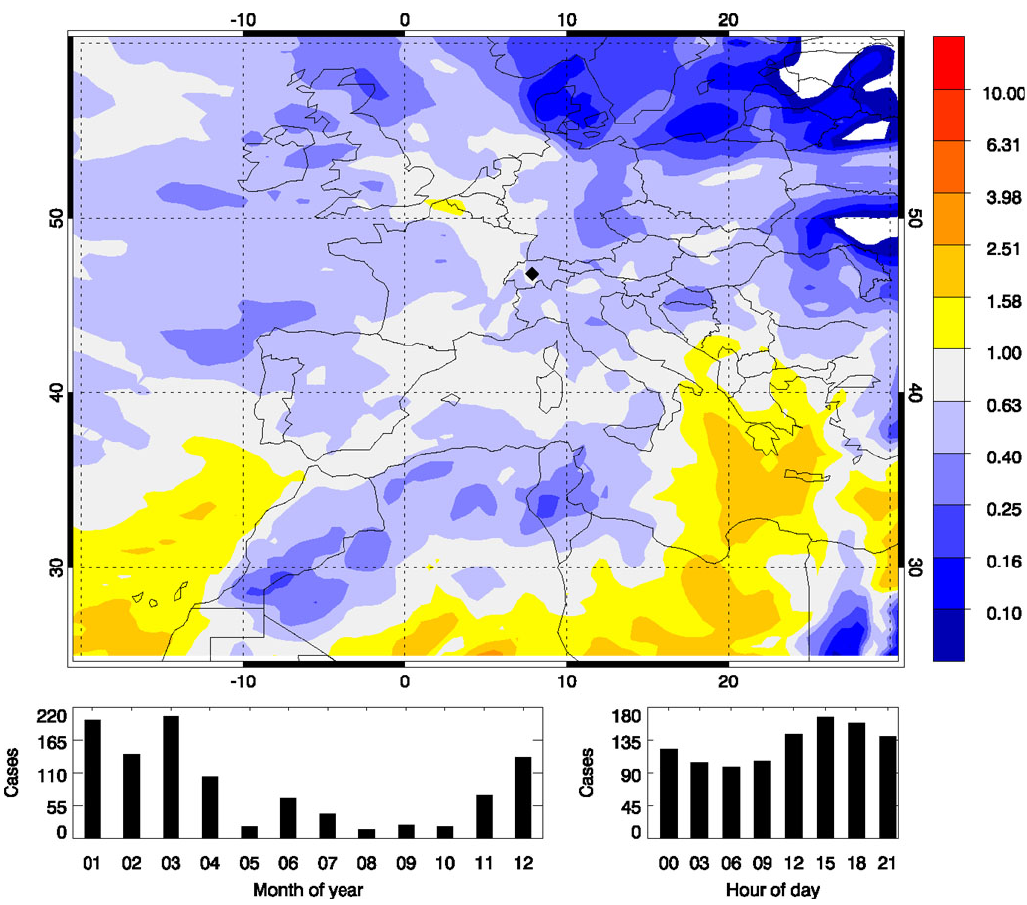
Fig. 15. Relative footprint map associated with regular CO 2 and low O 2 concentrations (subset 6). See Fig. 10 for further